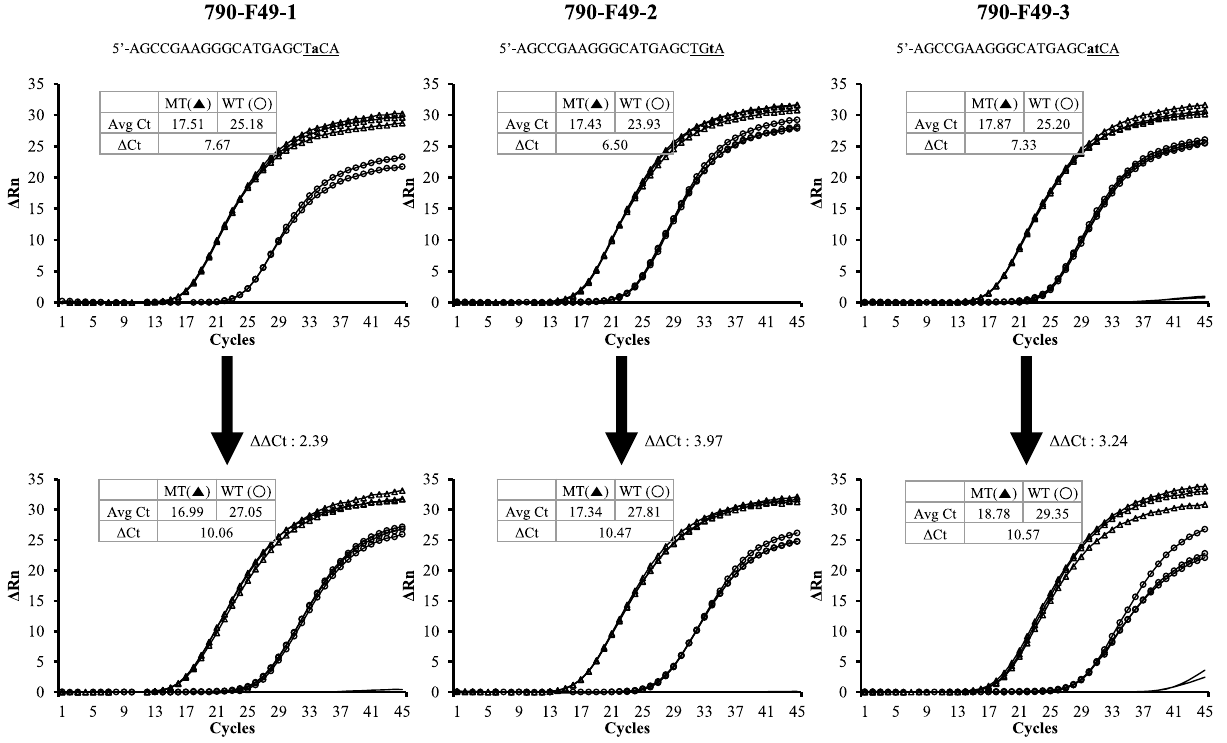
Figure 3. Efficiency of ARMS-PCR using standard and STexS utilized methods. Each ARMS primer is designed to target the EGFR gene variation T790M. Additional one or two mismatch base(s) were inserted to the primers and were mixed with the WT primers for quantification. Both general ARMS-PCR and STexS PCRs were identically performed. qPCRs were performed with 790-F49-1, 790-F49-2 and 790-F49-3 for EGFR T790M, and 1 uM of AHP3 as dbOligo for STexS PCR was